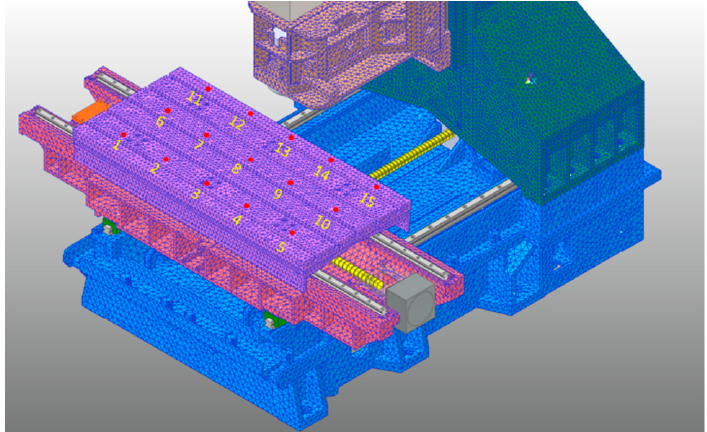
Figure 7. Worktable location.